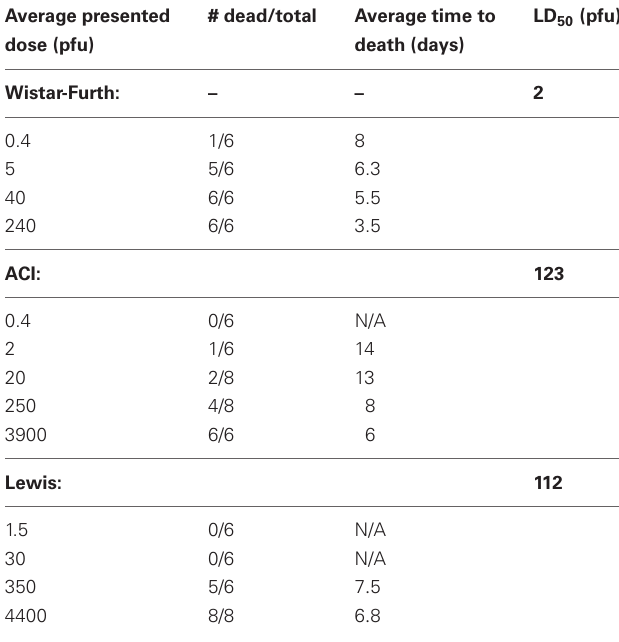
Table 1 | Average time to death of inbred rat strains infected with RVFV by aerosol